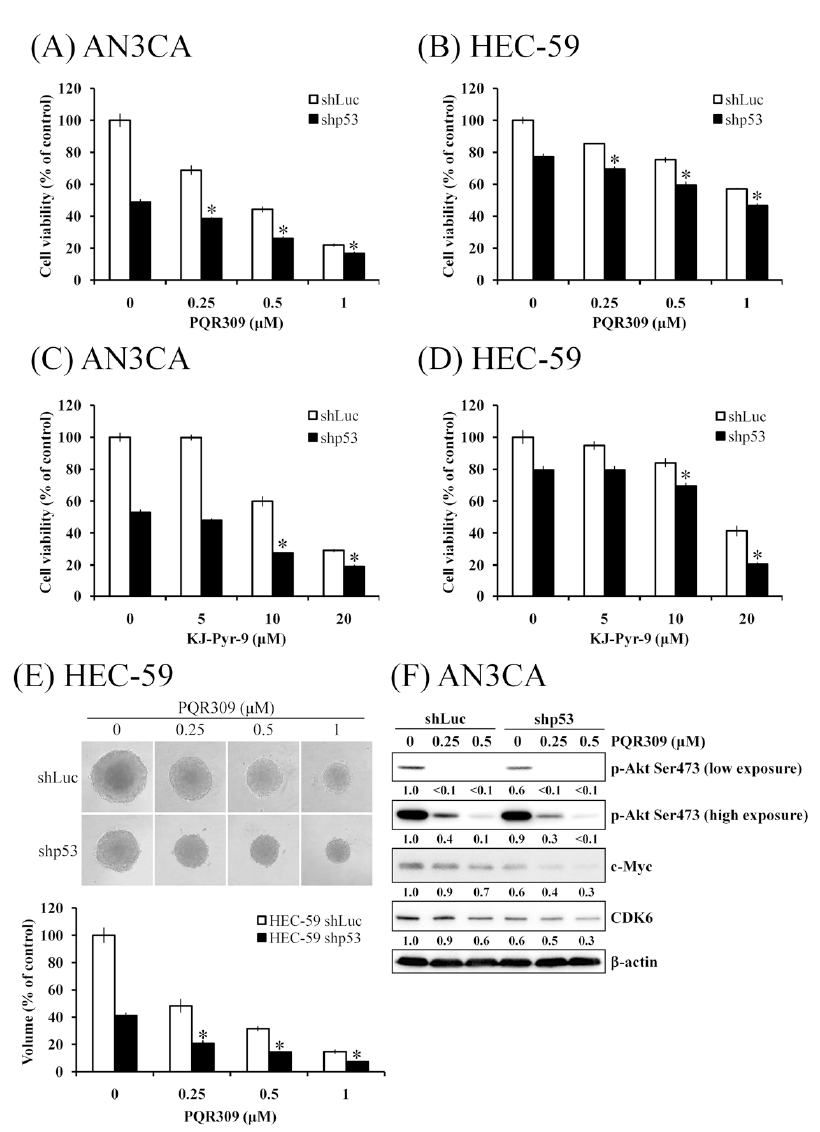
Figure 7. Effect of mtp53 knockdown on PQR309-mediated cell viability and tumor spheroid formation ( A , B ) AN3CA shLuc (5 × 10 3 cells/well of 96-well plate), AN3CA shp53 (5 × 10 3 cells/well of 96-well plate) and HEC-59 shLuc (6 × 10 3 cells/well of 96-well plate), HEC-59 shp53 (6 × 10 3 cells/well of 96-well plate) were treated with PQR309 (0, 0.25, 0.5 and 1 μM) for 72 h. Cell viability was analyzed by MTT assay. ( C , D ) AN3CA shLuc (5 × 10 3 cells/well of 96-well plate), AN3CA shp53 (5 × 10 3 cells/well of 96-well plate) and HEC-59 shLuc (6 × 10 3 cells/well of 96-well plate), HEC-59 shp53 (6 × 10 3 cells/well of 96-well plate) were treated with KJ-Pyr-9 (0, 5, 10 and 20 μM) for 72 h. Cell viability was analyzed by MTT assay. ( E ) HEC-59 shLuc and shp53 cells (1 × 10 3 cells/well of 96-well dish) were seeded onto ultra-low-attachment 96-well plates. After 96 h incubation for spheroid formation, PQR309 (0, 0.25, 0.5, and 1 μM)-containing medium was added to the well, and the spheroids were incubated for 7 days. Spheroids were investigated under an inverted microscope. The volumes of spheroids were determined by the formula 0.5 × larger diameter × small diameter2. Data show the relative spheroid volume, and the volume of spheroids of HEC-59 shLuc without PQR309 treatment was set at 100%. ( F ) Protein expressions of p-Akt, c-Myc, and CDK6 were determined by Western blot. ImageJ software was used to quantify the band intensities of p-Akt, c-Myc, and CDK6. Data shown are the relative expression standardized by the β-actin protein level. The ratio of shLuc cells without treatment was set at 1. The symbol ∗ indicates p < 0.05 for the PQR309-treated shp53 group when compared with the PQR309 or shp53 alone